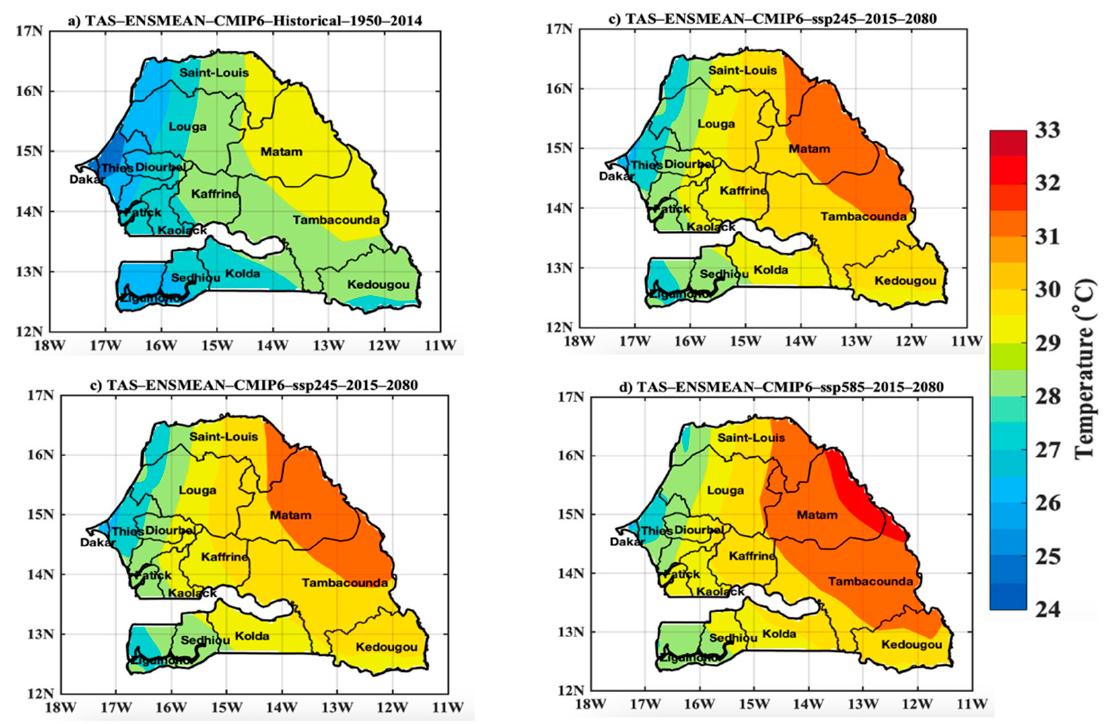
Figure 6. Spatial distribution of temperature in Senegal with ( a ) historical data (1950–2014), and projections (2015–2080) for the ( b ) scenarios SSP12.6, ( c ) SSP245, and ( d ) SSP585 of the CMIP6 ensemble models. The exact units here are °C per month average.